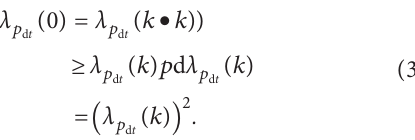
Table 4: Product P